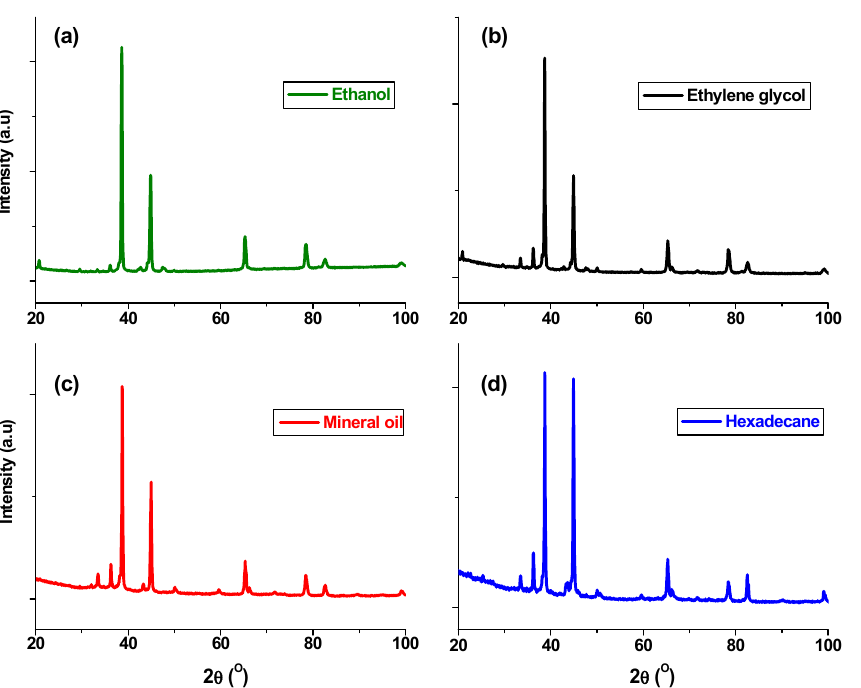
Figure 13. XRD patterns of coatings produced from Al powder and melamine in different suspension media: ( a ) ethanol, ( b ) ethylene glycol, ( c ) mineral oil and ( d ) hexadecane.